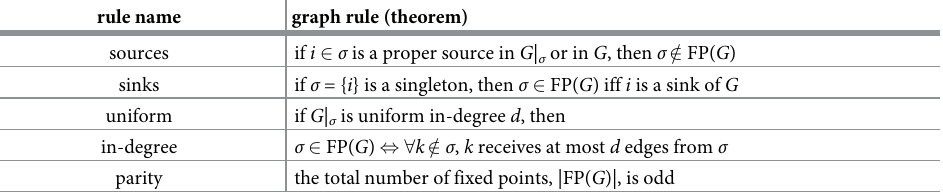
Table 1. Graph rules for